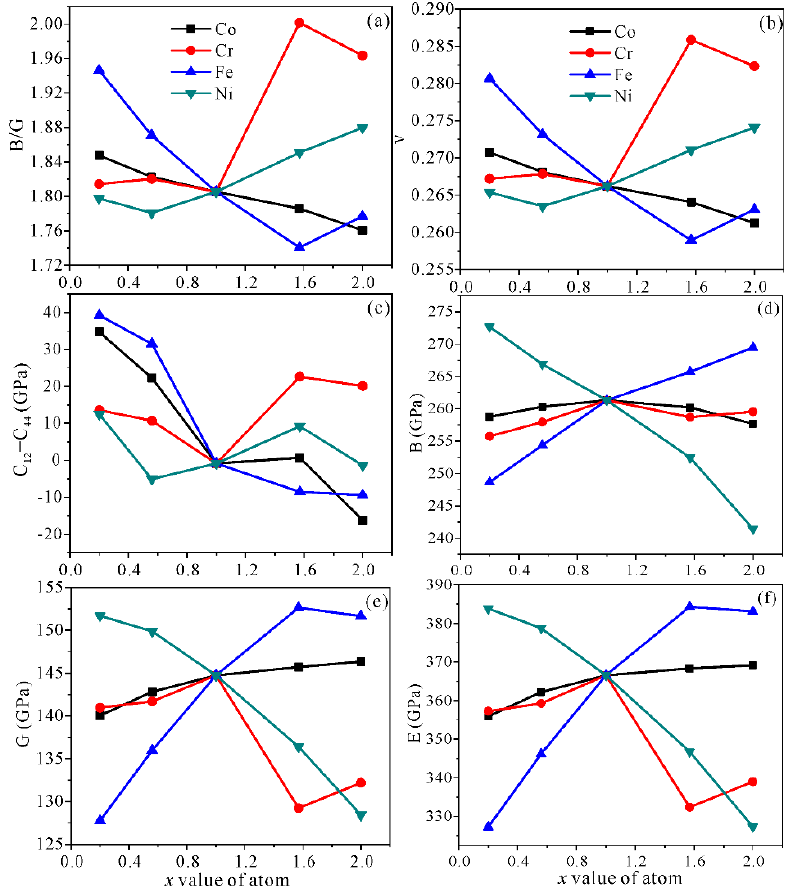
Figure 4. ( a ) Pugh ratio B/G, ( b ) Poisson’s ratio ν , ( c ) Cauchy pressure C 12 – C 44 , ( d ) Bulk modulus B , ( e ) shear modulus G , and ( f ) Young’s modulus E of Co-Cr-Fe-Ni HEAs with the x value of ele- ments.